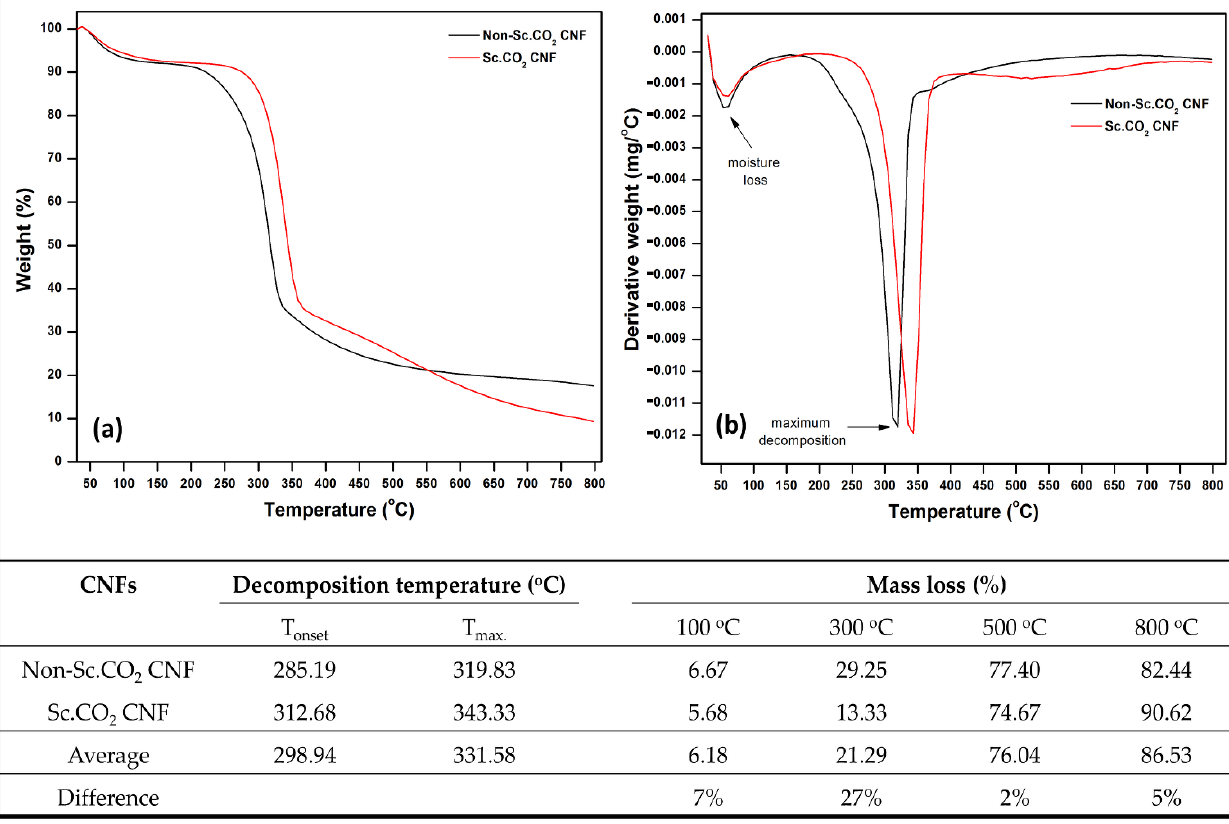
Figure 4. Thermogravimetric analysis of obtained CNFs ( a ) TGA, ( b ) DTG, and decomposition temperature and mass loss data of the CNFs.